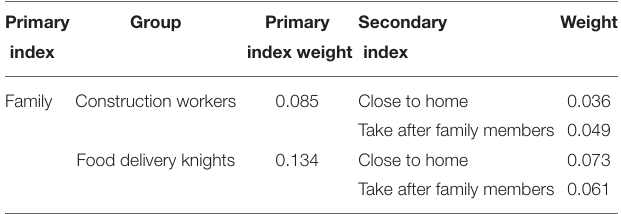
TABLE 13 | Weights of index